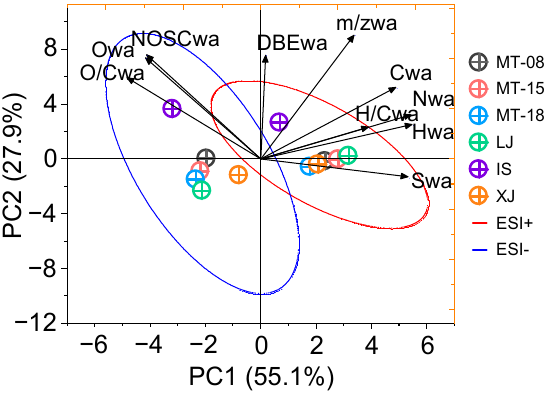
Figure 1. Principle component analysis of intensity-weighted average values is listed in Table 1 for the Baijiu samples measured by ESI+ and ESI − . The red confidence ellipse is the parameter measured by the ESI+ mode and the blue confidence ellipse is the parameter measured by ESI − mode. Analysis of the main subcategories revealed that ESI+ analysis of the trace compo‑ nents of the six Baijiu samples showed similar relative abundances of CHO and CHNOS class species, accounting for 35.2–48.0% and 31.5–42.6% of the mass spectral contribution, respectively. On the other hand, the mass spectra acquired by ESI − were dominated by CHO and CHOS class species, accounting for 56.4–68.1% and 11.3–32.7% of the total de‑ tected ion intensity, respectively (Figure 2). It is noteworthy that the molecules revealed by ESI+ provided a contribution of 2.9–4.4% to the total ion response from the CHN class of trace components of Baijiu. Regarding the CHO class, the relative abundance of its oxygen content and oxygen number showed a normal distribution with a concentrated distribution between 3 and 9. IS exhibited a different behavior, with a more widely discrete distribu‑ tion of oxygen numbers. Overall, the oxygen number of CHO class compounds detected in the negative mode was relatively higher (Figure 3).